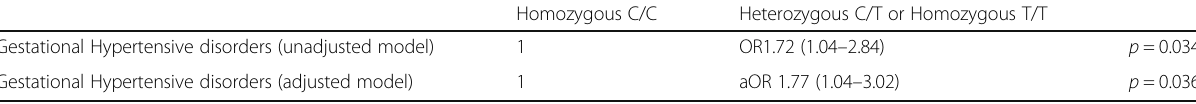
Table 3 Regression analysis among cases/controls and genotype combinations of HRG C633T SNP